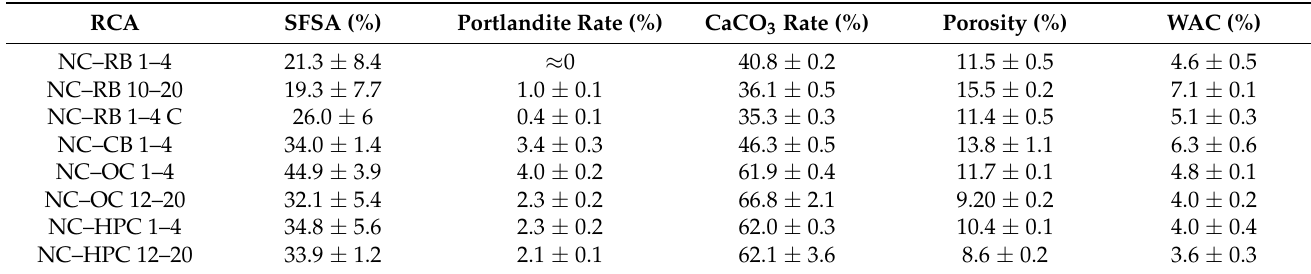
Table 3. Properties of the non-carbonated RCAs.